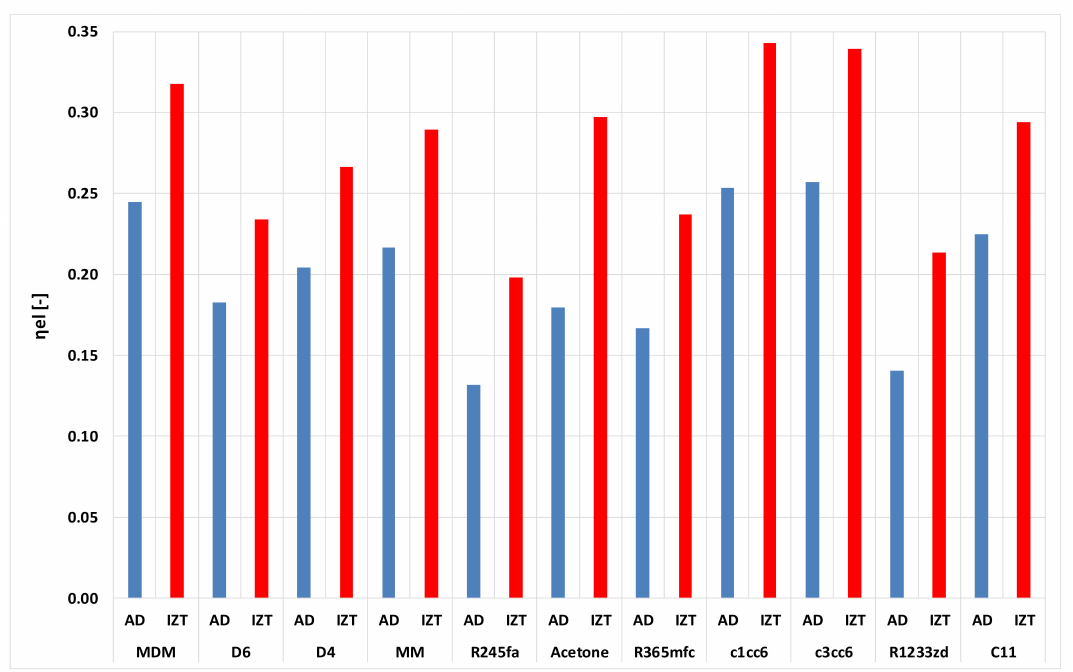
Figure 5. Variant 1—overall e ffi ciency for adiabatic and isothermal expansions (red bars—isothermal expansion, blue bars—adiabatic expansion).